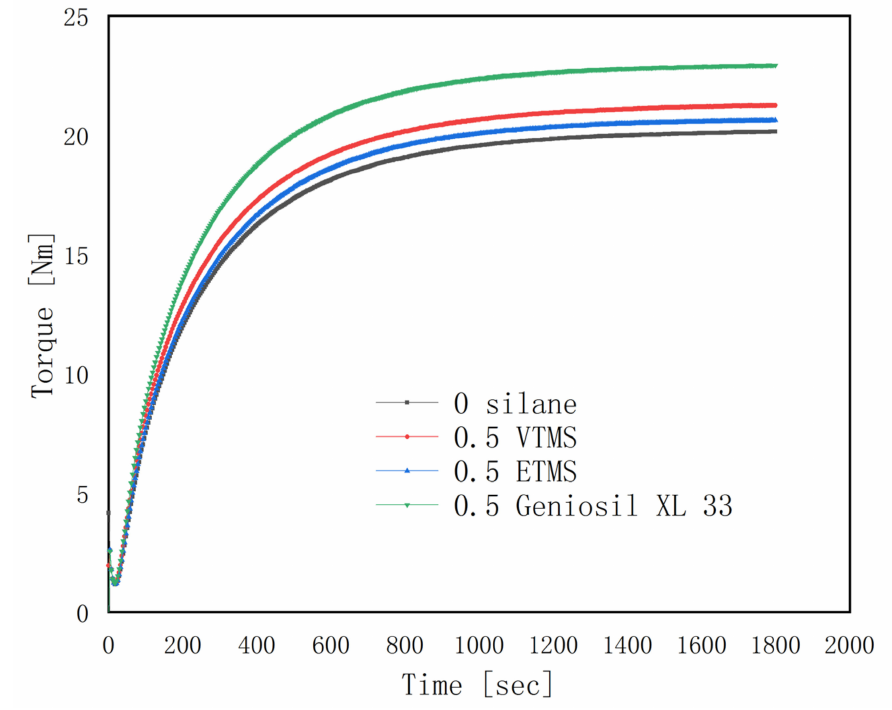
Figure 1. Vulcanization curve of the EPDM/CaCO 3